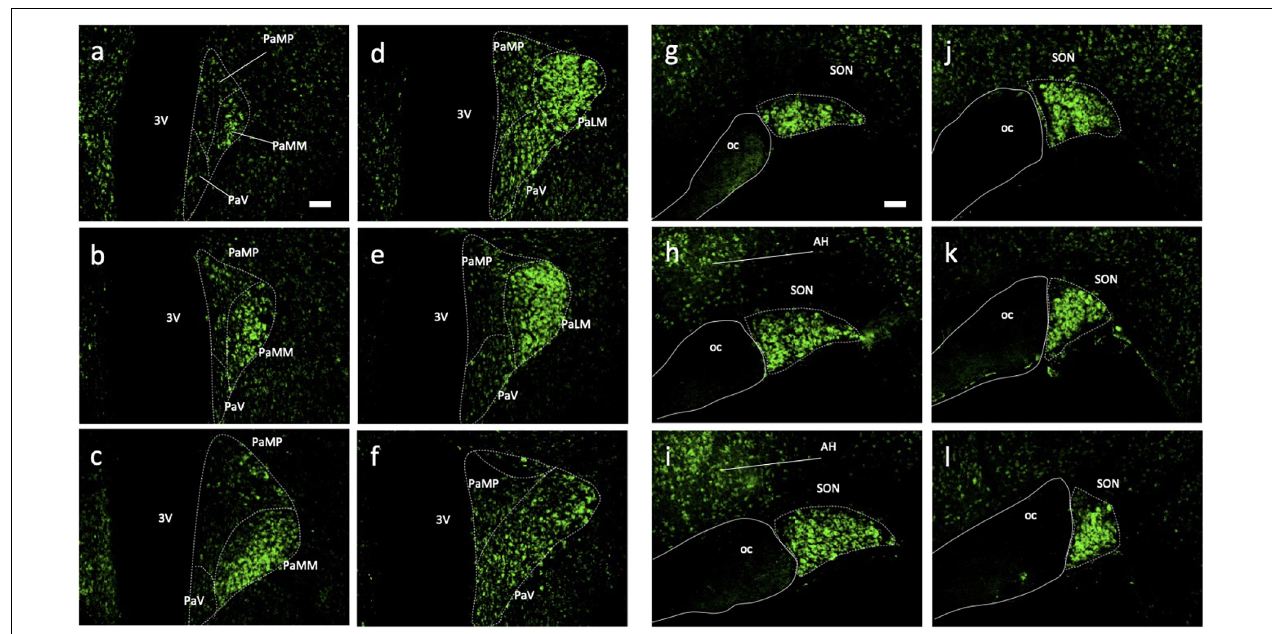
FIGURE 3 | Immunohistochemical analysis of Urocortin expression in hypothalamic paraventricular and supraoptic nuclei of rat. Coronal sections (rostral-caudal) through rat hypothalamus showed high Ucn (green) expression within magnocellular portions of the PVN (a–f) and SON (g–l) . Lower expression was detected adjacent to both nuclei appearing localised to cell bodies only. 3V, Third Ventricle; PaMP, medial parvocellular PVN; PAMM, medial magnocellular PVN; PaV, ventral PVN; PaLM, lateral magnocellular PVN; oc, optic chiasm; PVN, paraventricular nucleus; SON, supraoptic nucleus; AH, anterior hypothalamic area; Ucn, Urocortin. Scale Bar = 100 µ